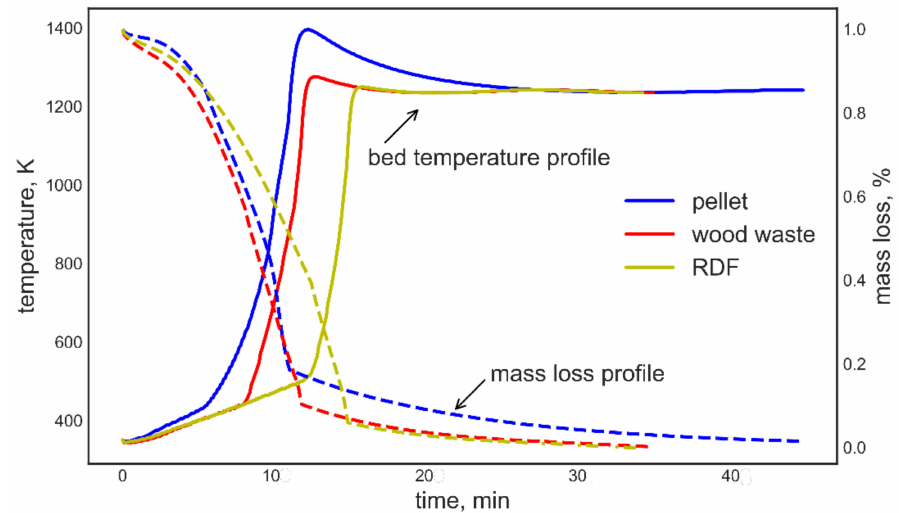
Figure 6. Mass loss (dashed-line) and temperature evolution (solid line) profiles of thethree fuels.